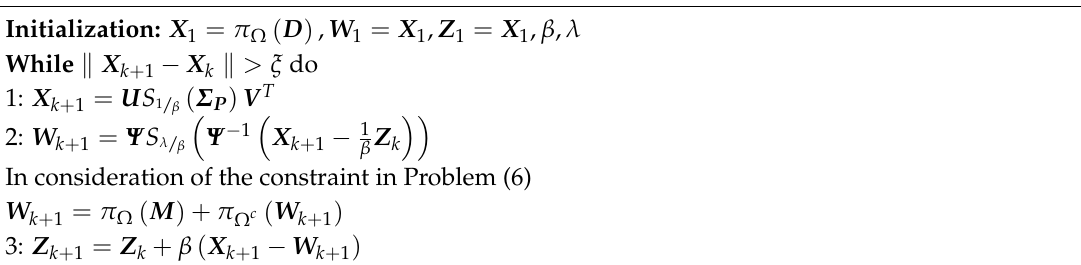
Algorithm 1: The proposed GBTR-ADMM